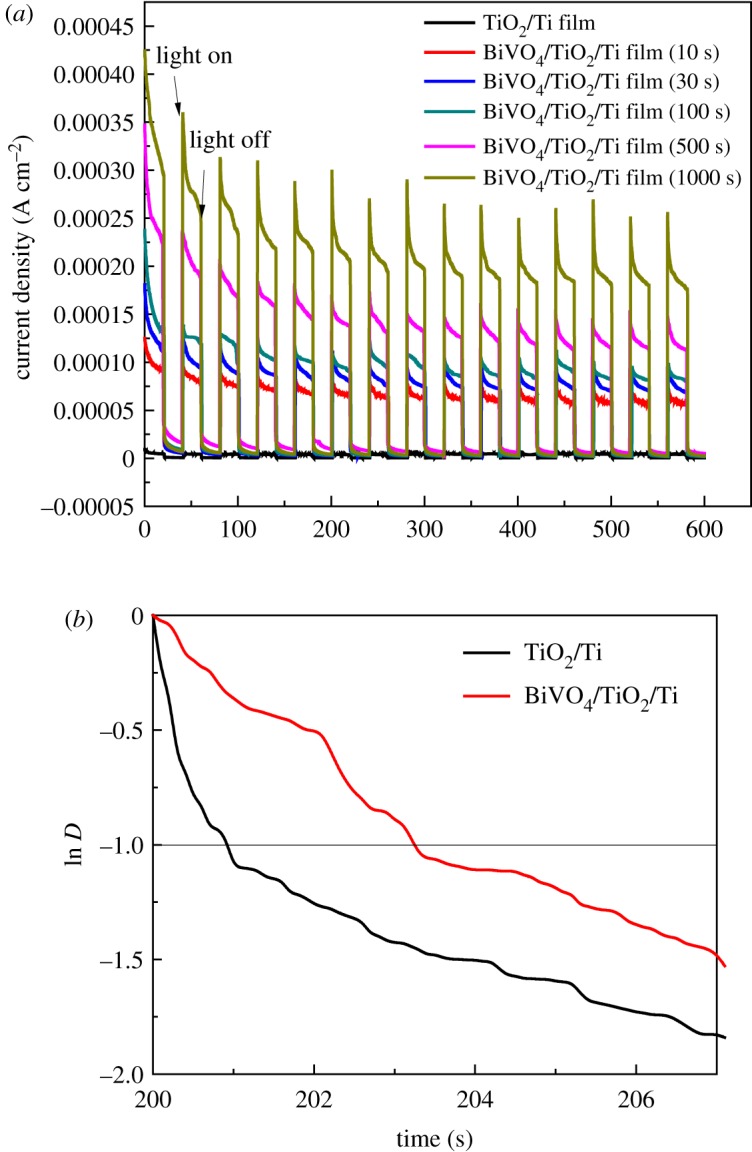
(a) Transient photocurrent responses of TiO2/Ti film and BiVO4/TiO2/Ti heterojunction film prepared with different electrodeposition times under 150 W Xe lamp illumination in 0.2 M Na2SO4 solution at 0.6 V versus SCE. (b) Transient decay times of TiO2/Ti film and BiVO4/TiO2/Ti heterojunction film.